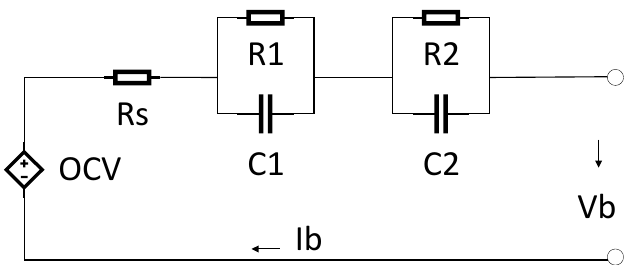
Figure 1. Suggested structure of the model for the lithium titanate oxide battery. OCV : open circuit voltage.